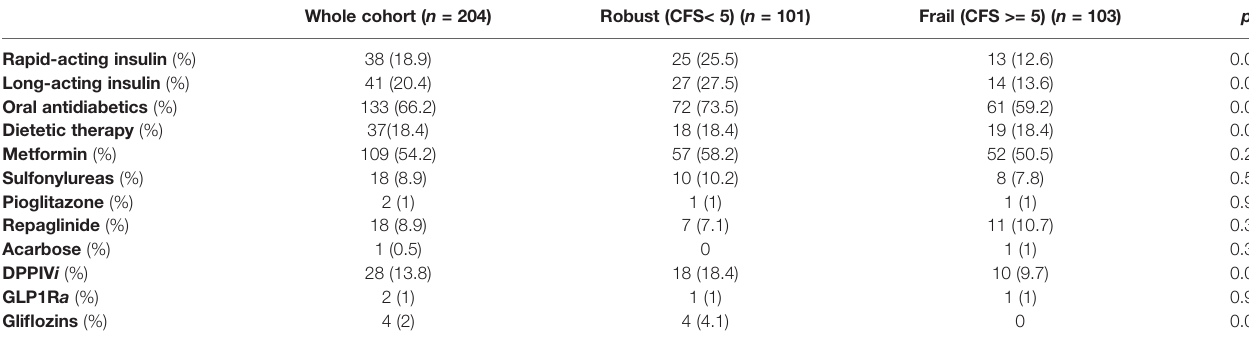
TABLE 3 | Antidiabetic therapy in orthogeriatric patients according to frailty degree. Whole cohort ( n = 204) Robust (CFS< 5) ( n = 101)